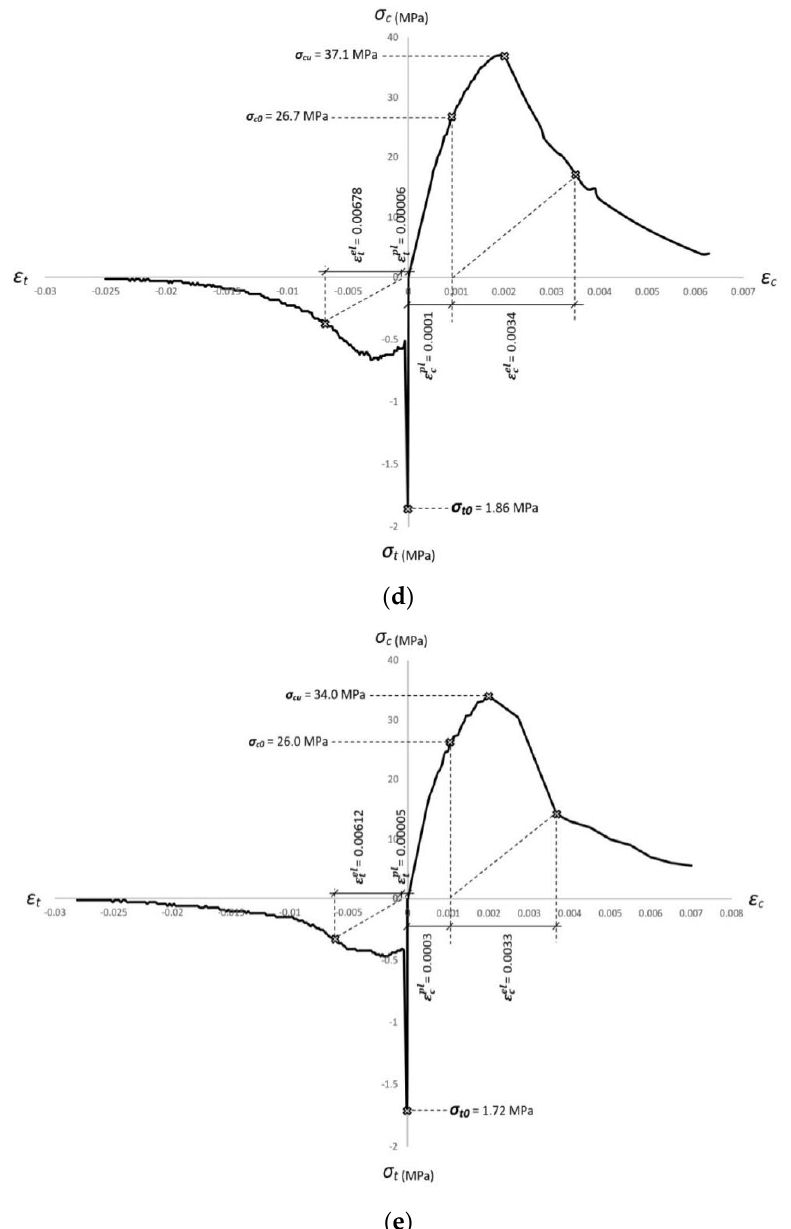
Figure 7. Constitutive models for the developed HyFRC in compression and tension: ( a ) FFC, ( b ) F6U3, ( c ) F6S3, ( d ) F6E3, ( e ) F6N3. Table 7. Material properties of FFC HyFRC.